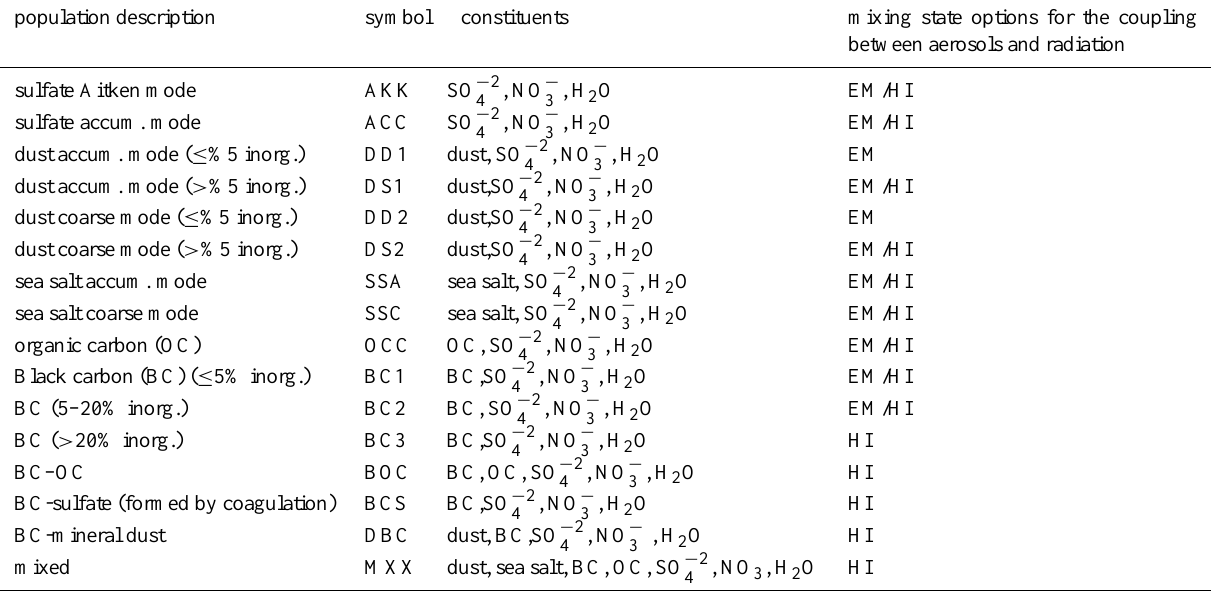
Table 1. Populations, constituents, and possible particle mixing state considerations in the radiation calculations: homogeneously internally mixed (HI), externally mixed (EM). population description symbol constituents mixing state options for the coupling